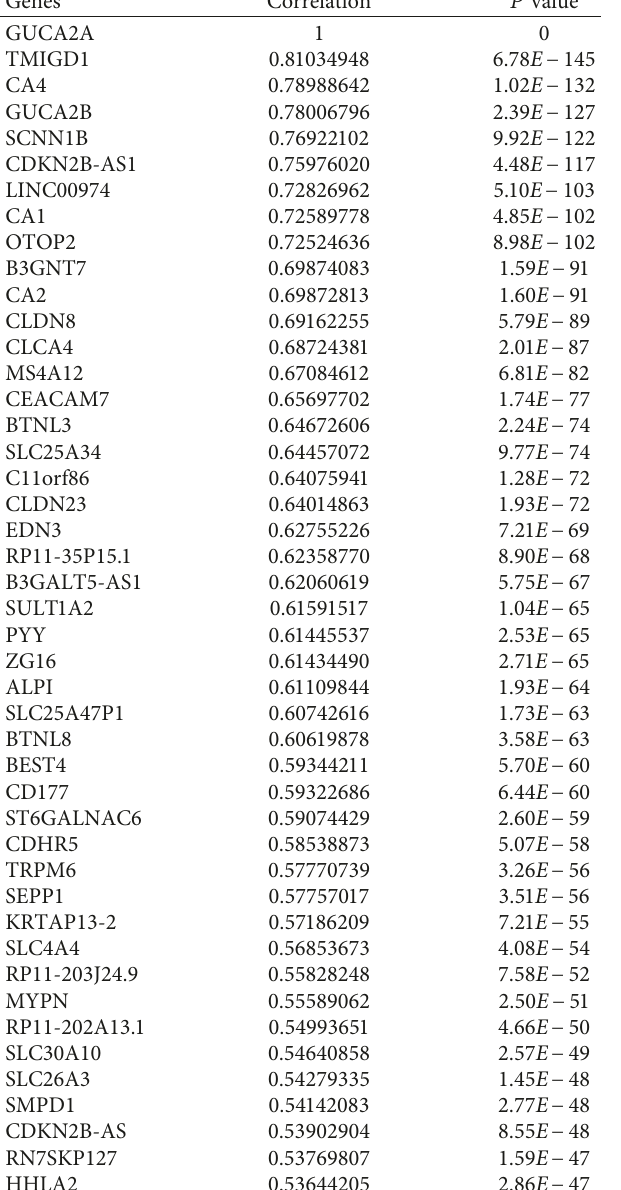
Table 3: GUCA2A coexpressed genes in the TCGA database.